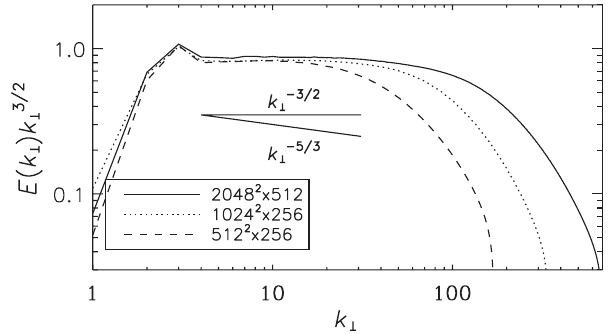
FIG. 4. Energy spectra E þ ð k ? Þ and E (cid:1) ð k ? Þ in imbalanced MHD as the Reynolds number increases (cases MI1, MI2, and MI3 in Table